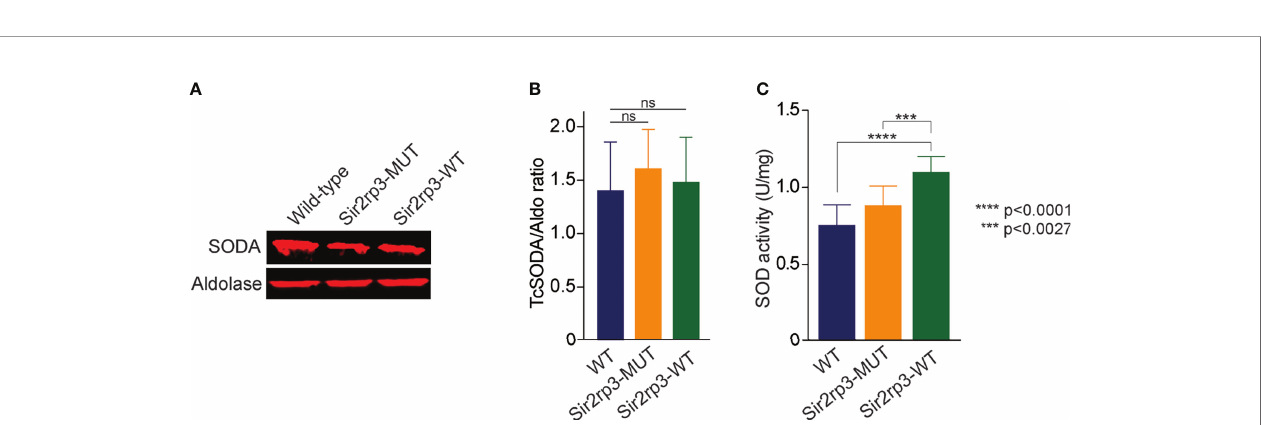
FIGURE 4 | TcSir2rp3 overexpression increase superoxide dismutase activity in T. cruzi . (A, B) Comparative analyses of TcSODA protein expression in the wild- type, Sir2rp3-WT and Sir2rp3-MUT parasites. No signi fi cant differences were observed among the cell lines for all enzymes analyzed. Aldolase was used as loading control. TcSODA levels were determined for all cell lines from a triplicate experiment. (C) SOD activity of total extracts of parasites. The assays were carried out in triplicate. Statistical analyses were performed using the Student ’ s t -test. *** p = 0.0027; **** p < 0.0001. ns, not signi fi